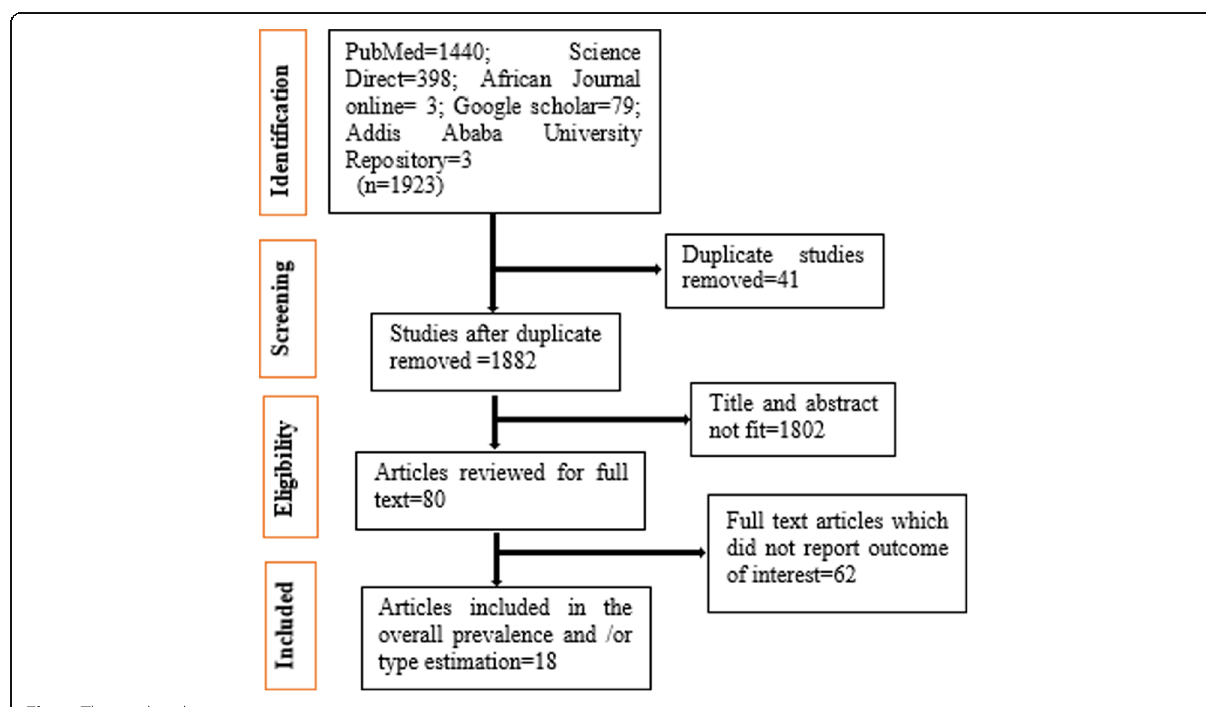
Fig. 1 The study selection process